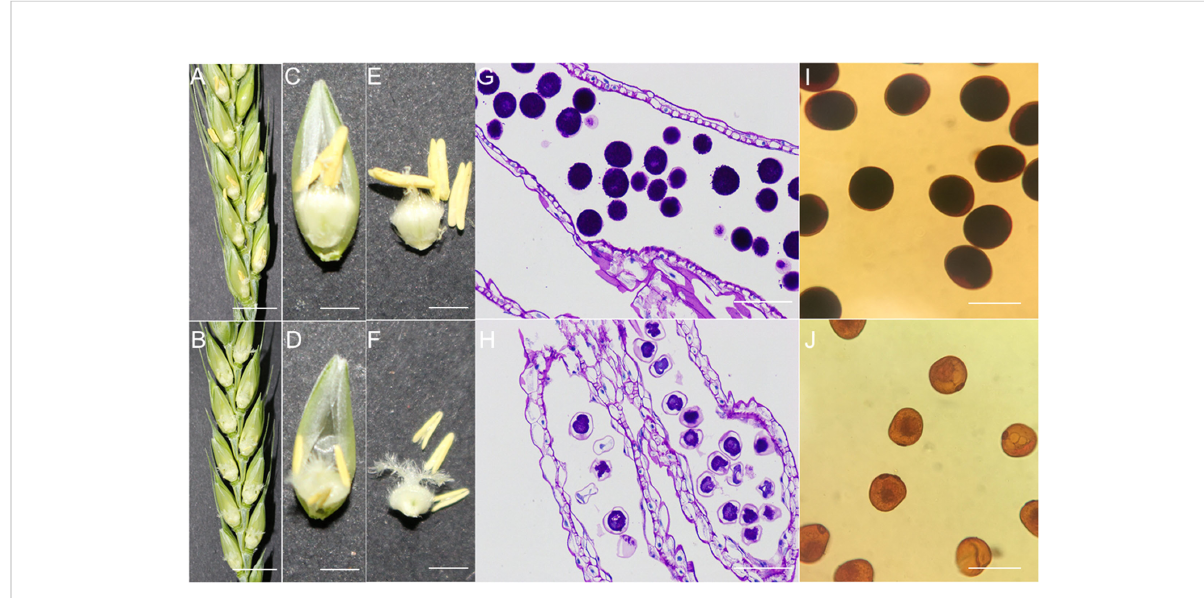
FIGURE 10 Comparison between phenotypic traits and transections of the anthers and pollen grains in Normal and HT-ms plants. (A, C, E) The morphology of Normal plants in anthesis on spikelets, fl orets and anthers, respectively. (B, D, F) The morphology of HT-ms plants in anthesis on spikelets, fl orets and anthers, respectively. (G) Longitudinal sections of Normal anther locule at the trinuclear stage. (H) Longitudinal sections of HT-ms anther locule at the trinuclear stage. (I, J) Pollen grains from the Normal anthers and HT-ms anthers stained with potassium iodide iodine (KI-I 2 ) solution. Bars = 10mm in (A , B) , 5mm in C-E , F , and 100µm in G-J